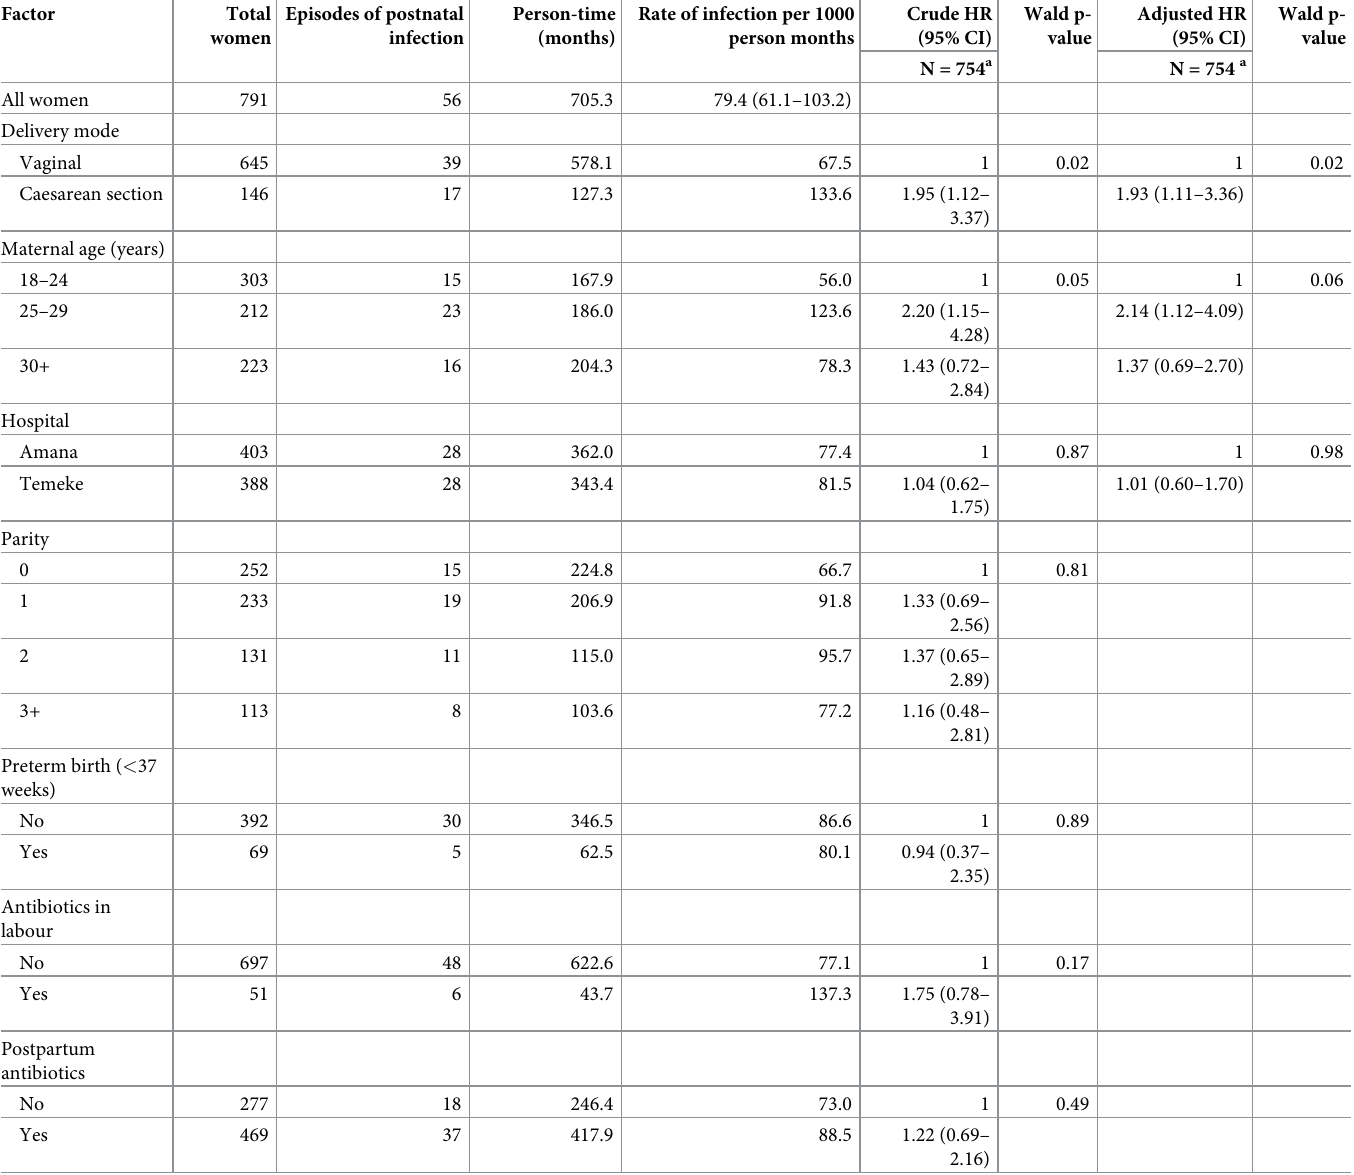
Table 5. Association between potential risk-factors and rate of possible maternal postnatal infection.